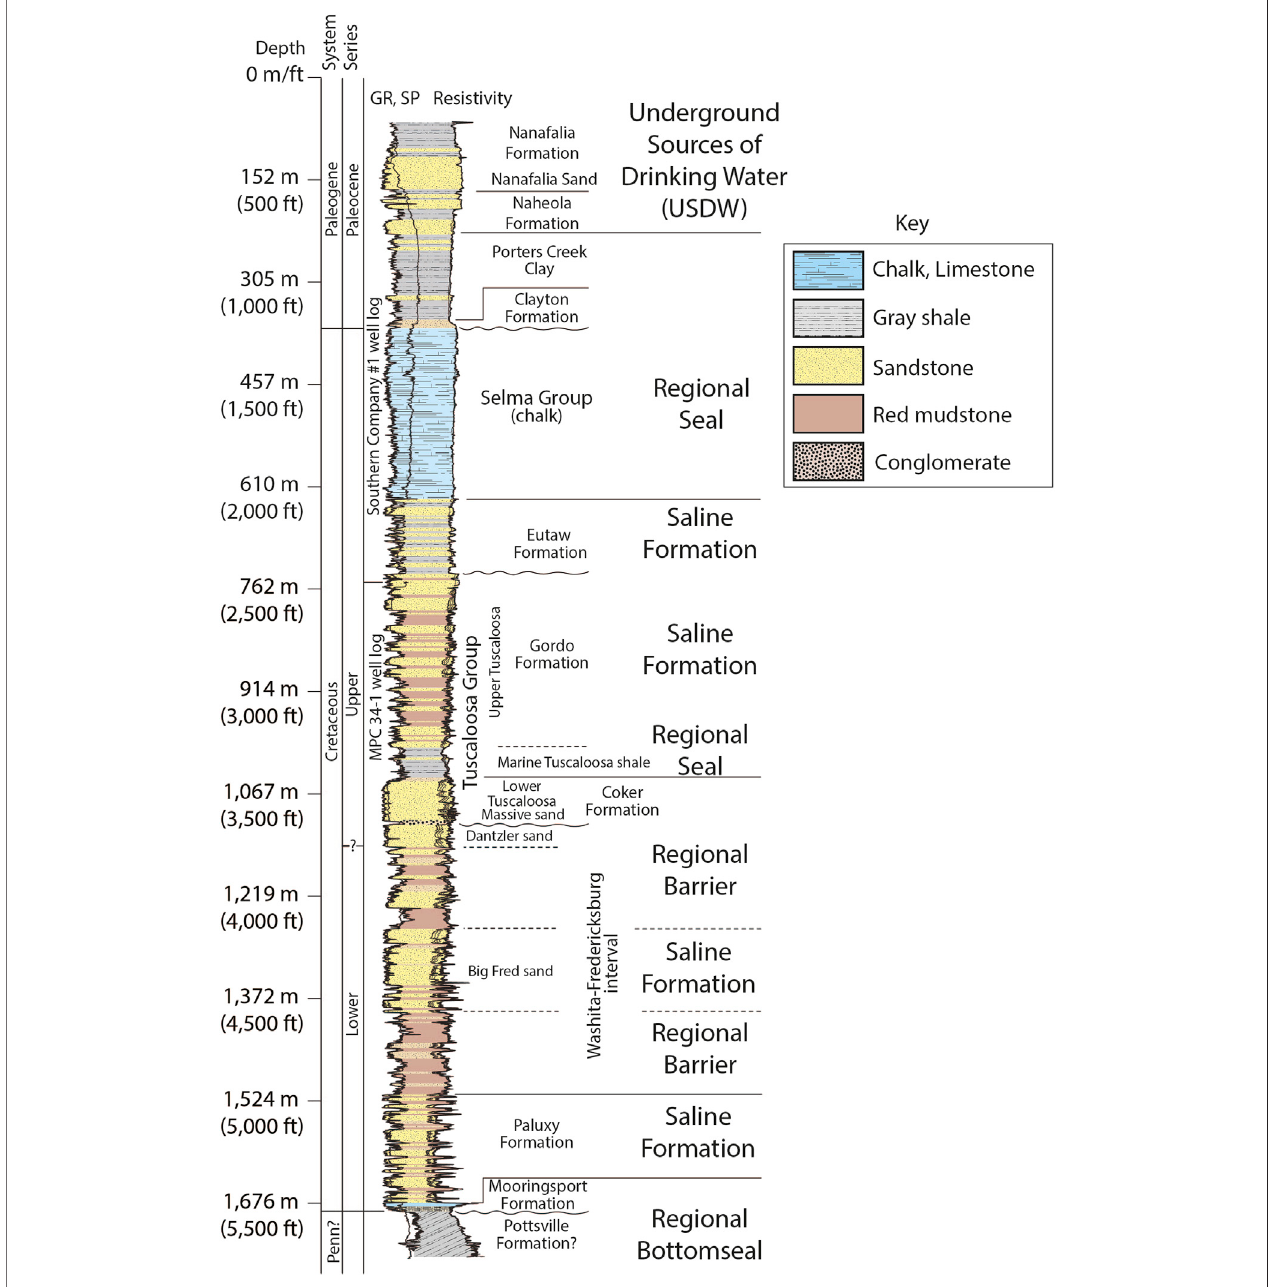
FIGURE 2 | Composite stratigraphic section and geophysical well log of the Paleozoic-Mesozoic section at the Kemper County energy facility (after Pashin et al., 2020).